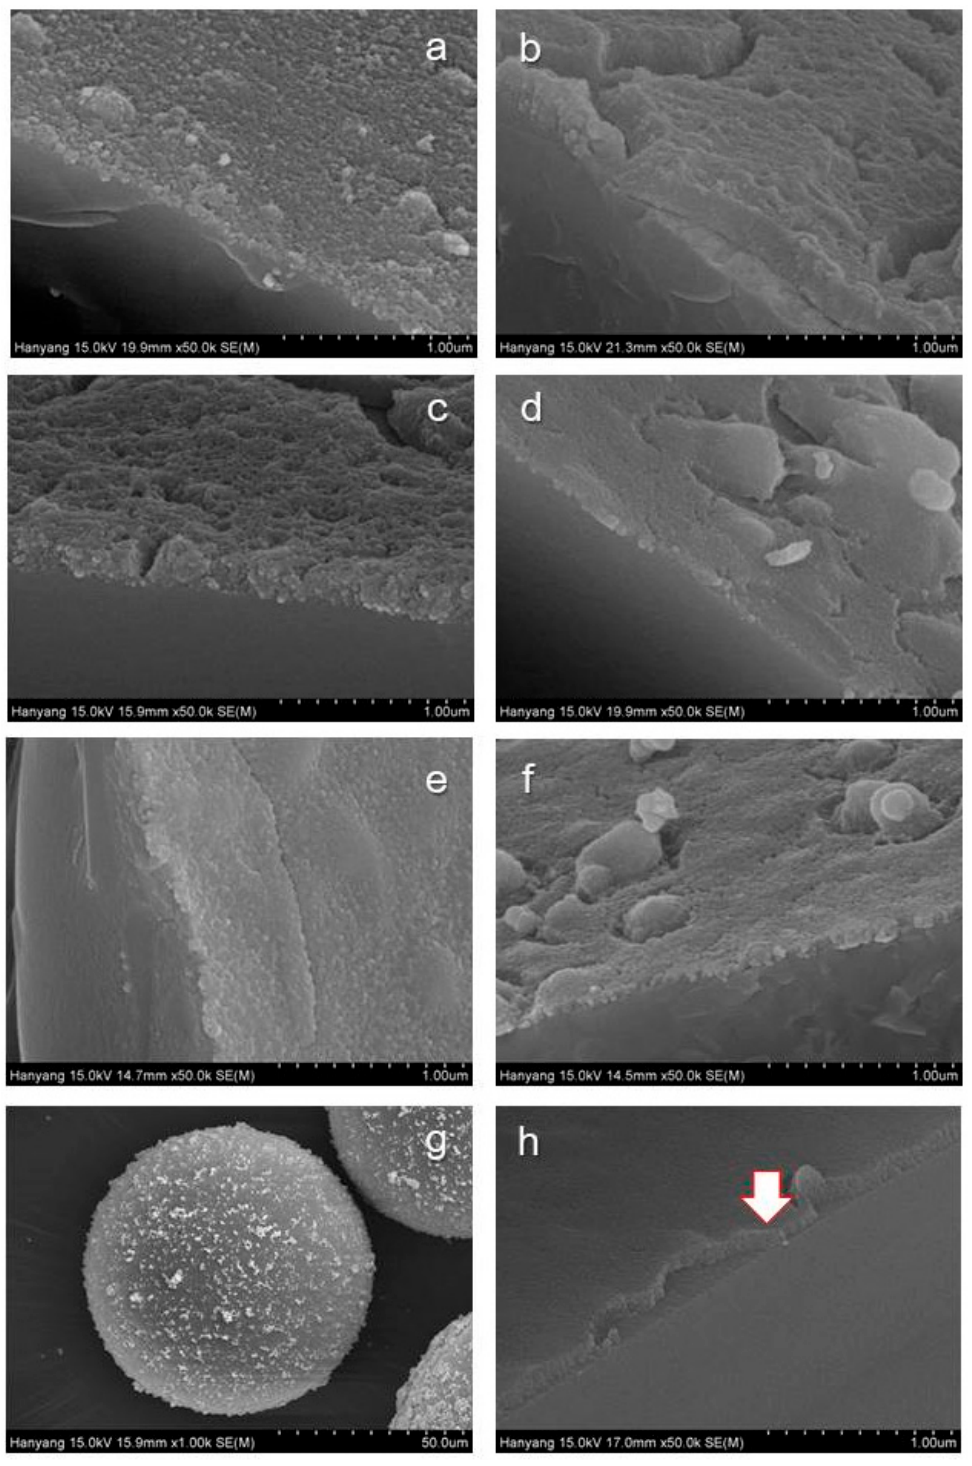
Figure 3. Surface morphologies of photocatalytic media prepared under di ff erent conditions: ( a ) Aging time = 60 min, ( b ) aging time = 120 min, ( c ) pH = 1, ( d ) pH = 7, ( e ) amount of water = 0.6 mL, ( f ) amount of water = 3.6 mL, and those prepared in optimized conditions in di ff erent magnifications ( g ) and ( h ), arrow for deposition of photocatalyst layer in (h).